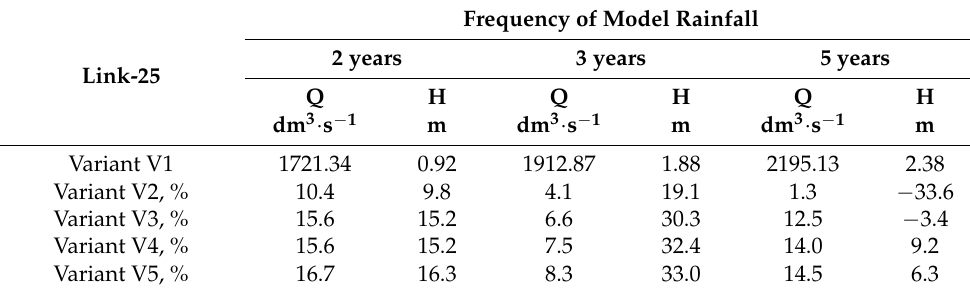
Table 3. Reduction of the maximum flow intensity and maximum depth in relation to the base variant—Link-25 calculation segment.